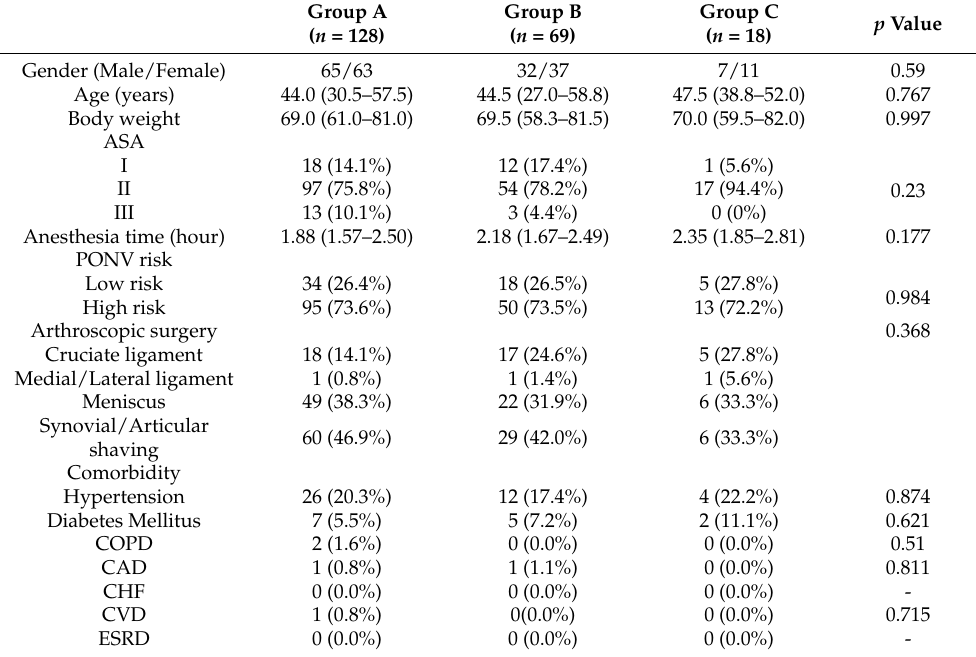
Table 1. Demographic characteristics of patients who underwent arthroscopic knee surgery under bispectral index-guided sevoflurane anesthesia, without adductor canal block (ACB) (Group A ), with preoperative ACB (Group B ), and with postoperative ACB (Group C